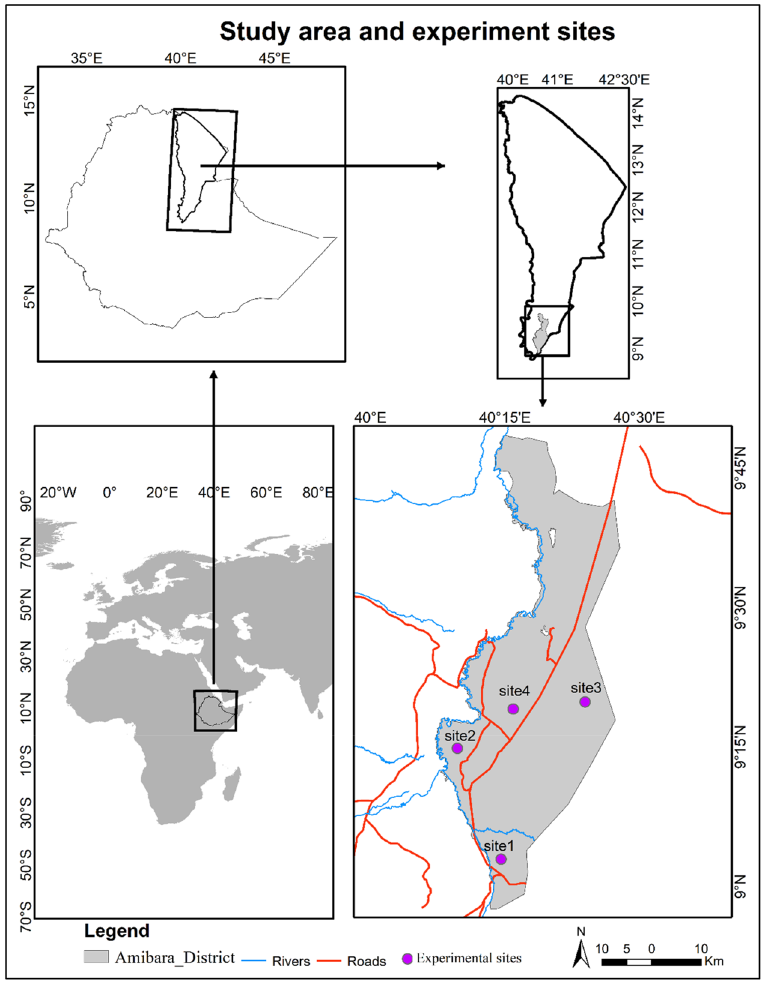
Figure 1. Location of study area and experimental sites in the Afar Region,